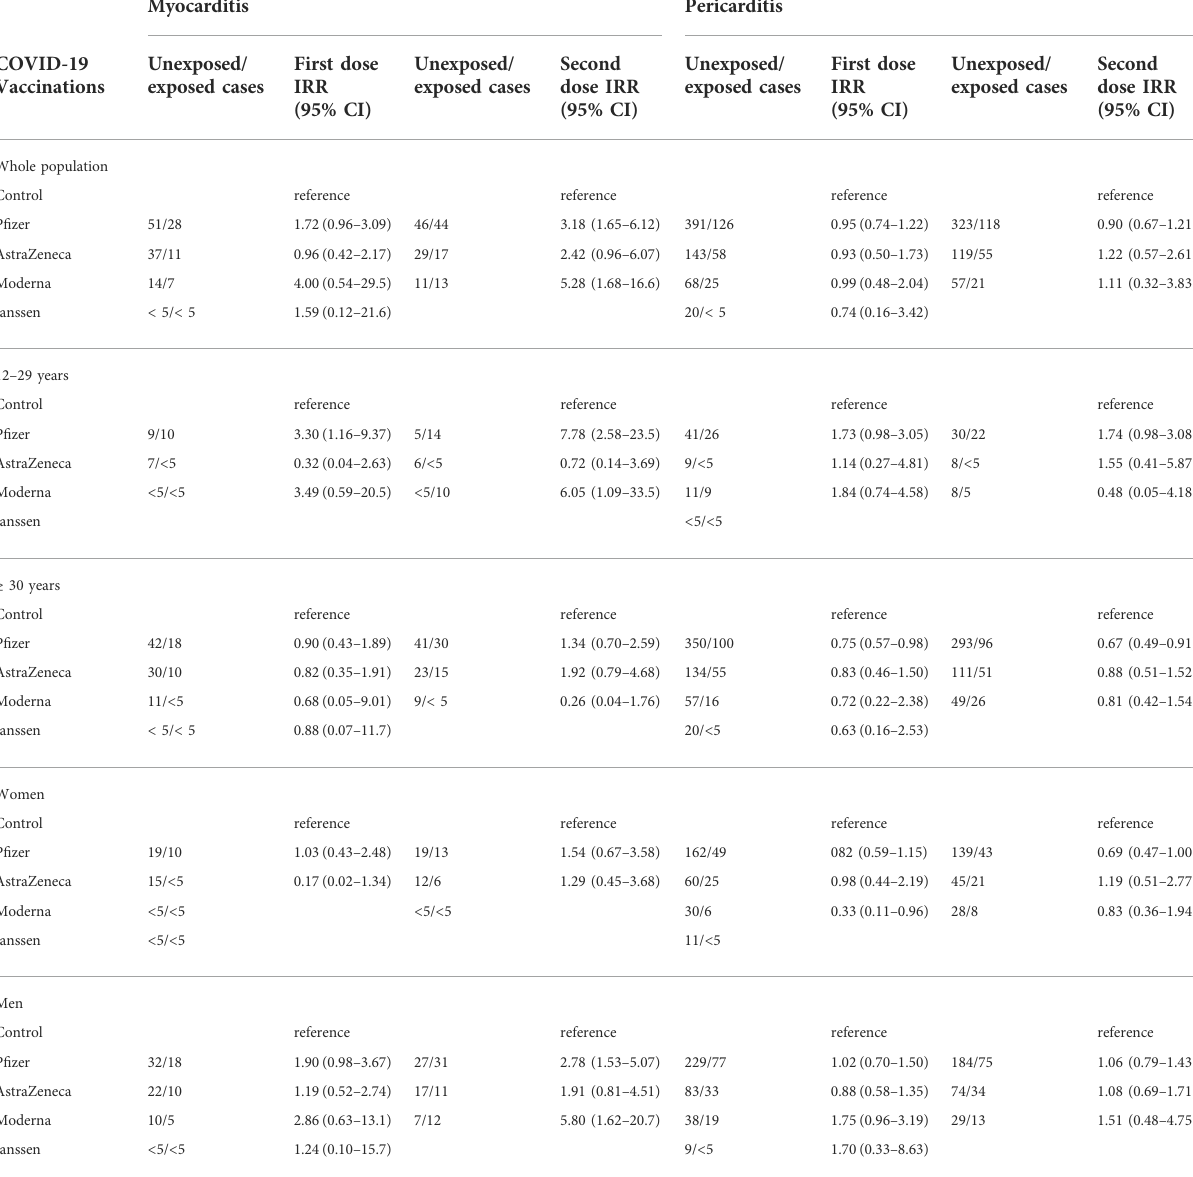
TABLE 4 Pooled calendar-time adjusted incidence rate ratios for myocarditis and pericarditis from the self-controlled risk interval analysis, strati fi ed by vaccine brand, dose, age, and sex. Myocarditis